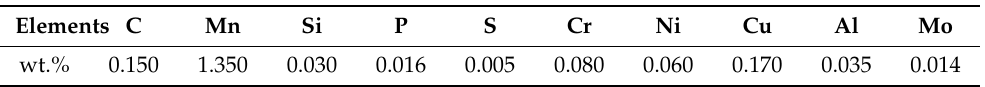
Table 1. Nominal composition of steel substrates for thermal spray process (S355N, EN 10025- 3:2004 [20]).